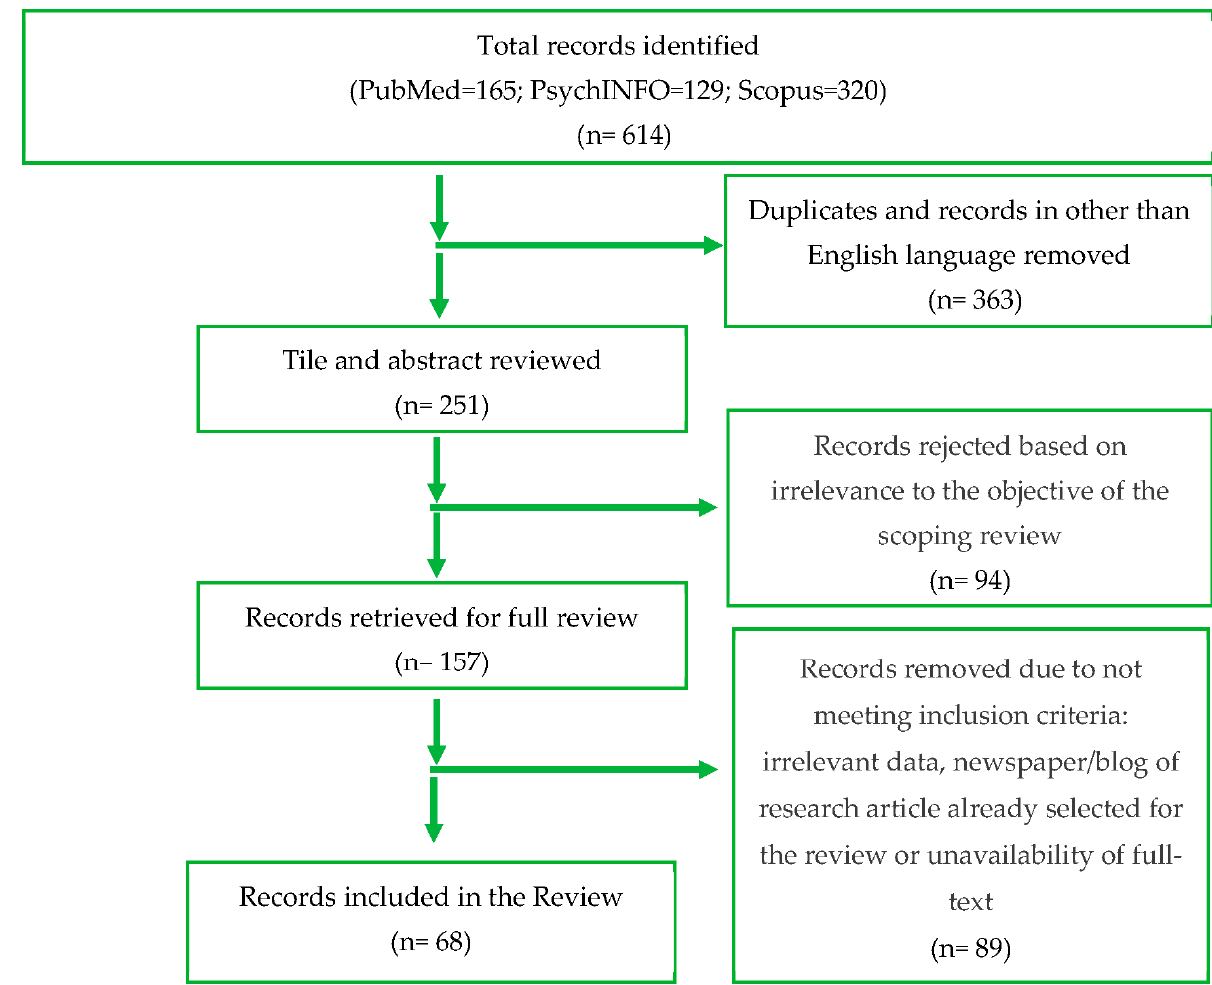
Figure 1. PRISMA diagram of the study.